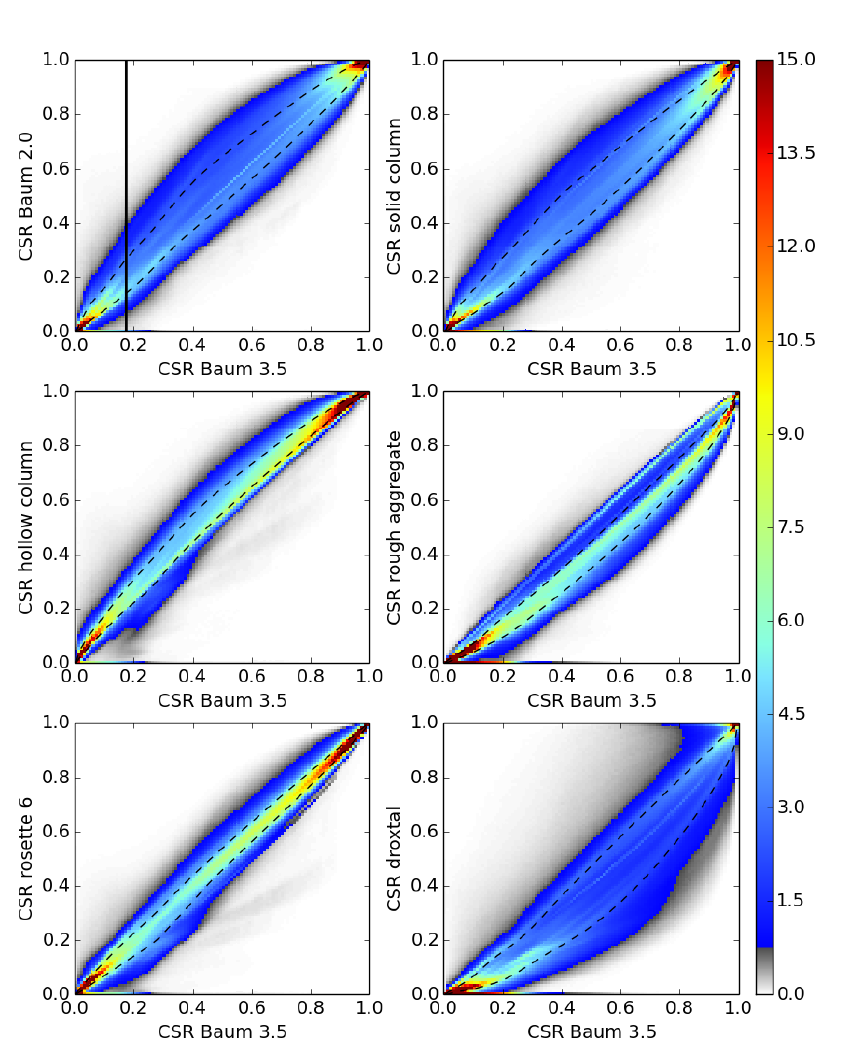
Fig. 8. Normalized circumsolar ratio (CSR) retrieval distributions for 100 bins of CSR from Baum v3.5 ( x axis, bin width 0.01). Dashed lines mark q 25 and q 75 ; that is, they enclose 50% of the measurements. Black vertical line in upper left panel marks the cross section that is displayed in Fig.